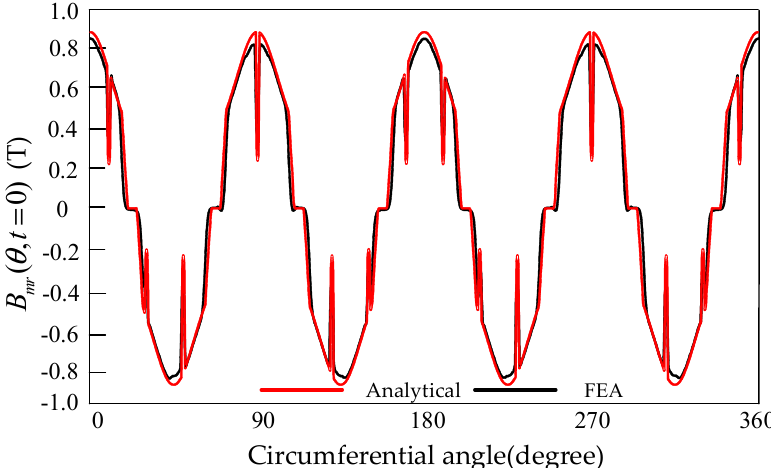
Figure 7. Comparison between analytical results and FEA of no-load air-gap flux density.